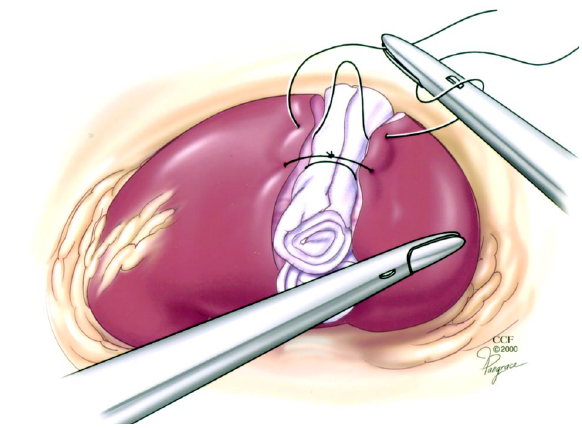
Figure 3 – Renal parenchymal repair over bolsters. Adapted from reference 10. (Reprinted with the permission of the Cleveland Clinic Foundation).